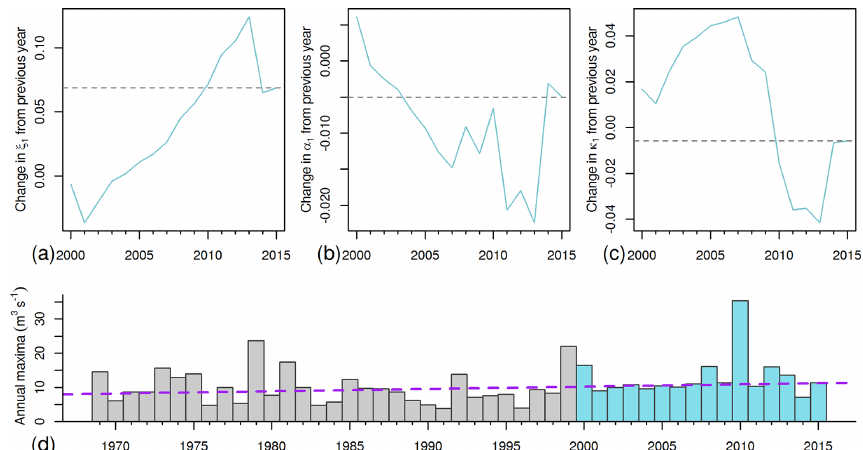
Figure 8. (a–c) Non-stationary parameters using fixed-start extending windows on the Warleggan at Trengoffe showing change due to addition of single data points, ξ 1 , α 1 and κ 1 plotted. (d) AMAX series highlighting period of extending windows.